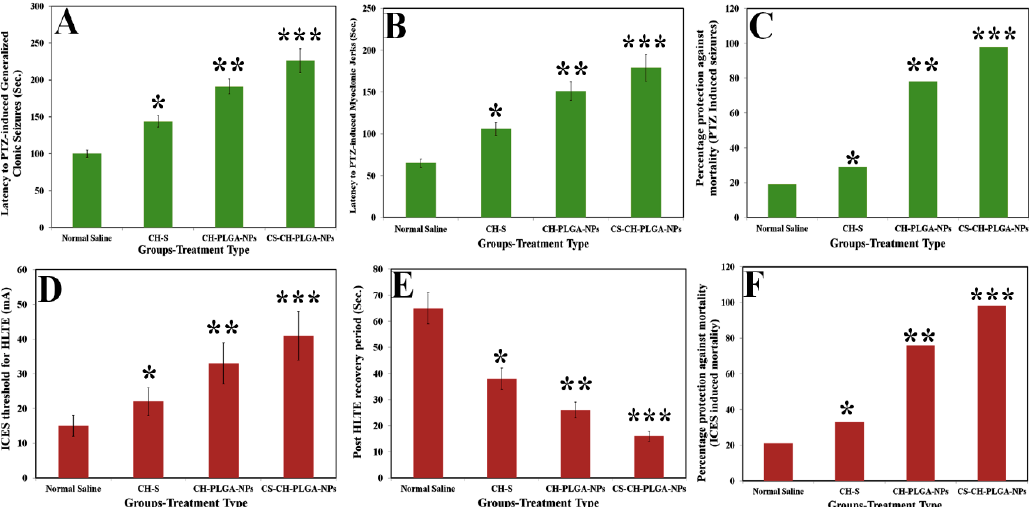
Figure 13. Effect of different nanoformulations of catechin hydrate on pentylenetetrazole (PTZ)-induced latency to generalized seizures ( A ), myoclonic jerks ( B) , % against mortality owing to PTZ-induced seizures ( C ), increasing current electroshock (ICES)-induced threshold for HLTE ( D ), ICES-induced post-HLTE recovery time ( E ), and % protective effect of different nanoformulations of catechin hydrate against ICES-induced mortality in rats ( F ). *** ( p < 0.001), ** ( p < 0.01), and * ( p < 0.05).